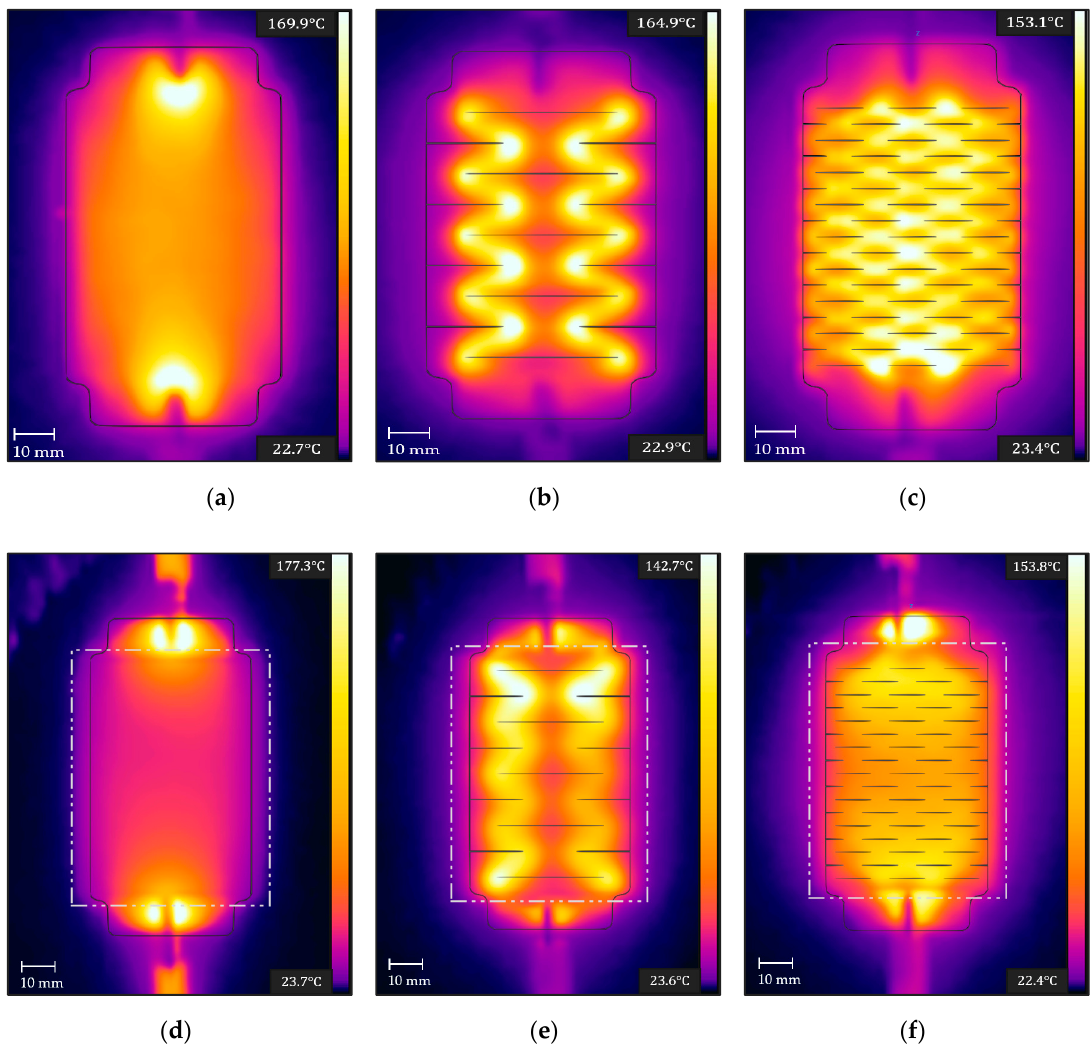
Figure 8. Thermal images of Thermionyx fabrics during heating. The cooler alligator clips can be seen at the top and the bottom of each image. The dashed lines represent the outline of the silicone material. ( a ) Blank design KB-6 overlaid on thermal image; ( b ) large cut design KL-6 overlaid on thermal image; ( c ) small cut design KS-6 overlaid on thermal image; ( d ) blank design KB-6 in actuator overlaid on thermal image; ( e ) large cut design KL-6 in actuator overlaid on thermal image; ( f ) small cut design KS-6 in actuator overlaid on thermal image.